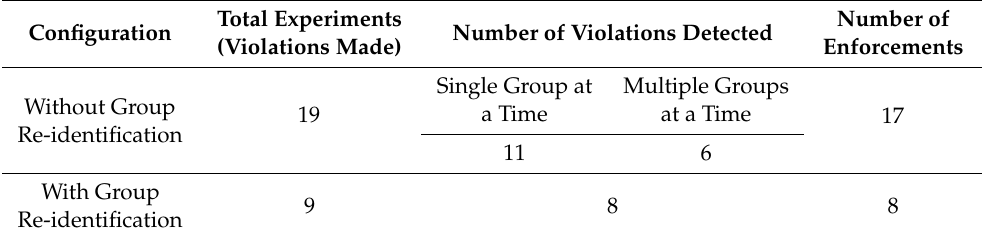
Table 4. Overall performance of proposed system with respect to different configurations.